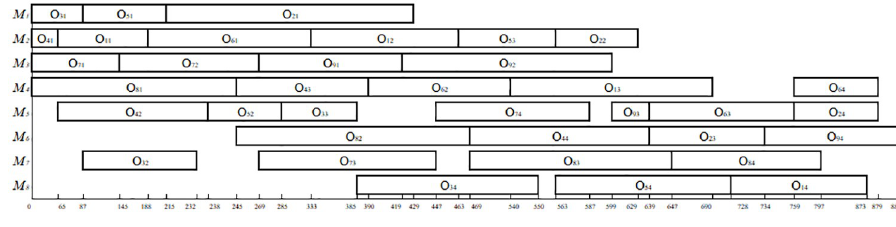
Fig 10. Gantt chart of MFJS08.